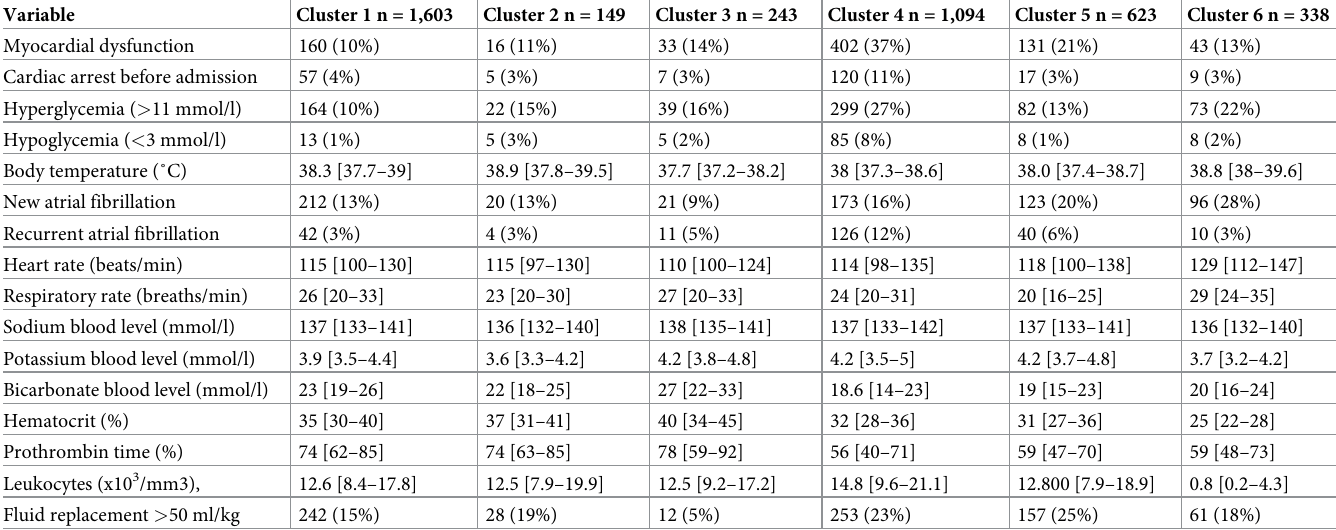
Table 3. Clinical and biological data at admission by cluster (performed in training set).